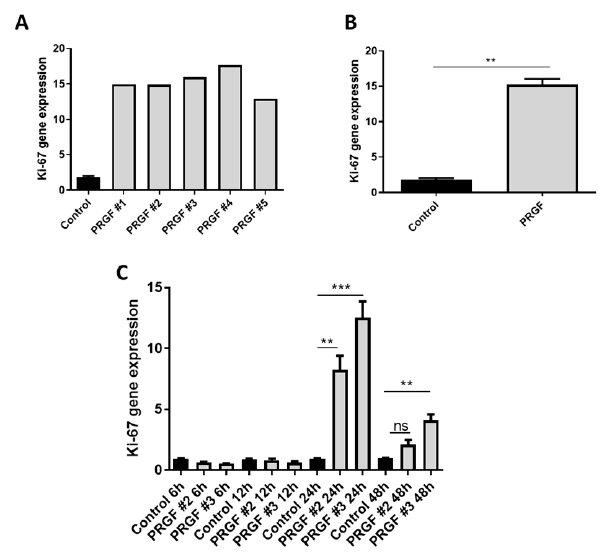
Figure 6. PRGF treatment of primary human fibroblasts induced Ki-67 gene expression. ( A , B ) Human primary fibroblasts were stimulated with PRGF from five different donors (PRGF #1-PRGF #5) for 24 h. Ki-67-gene expression was analyzed by real-time PCR. Shown are induction levels of separate donors ( A ) or combined of all 5 different donors ( B ) ( n = 5; ** p < 0.01, Mann-Whitney U test). ( C ) Primary human fibroblasts were stimulated with PRGF from two donors for 6, 12, 24 and 48 h. Ki-67-gene expression was analyzed by real-time PCR. Shown are means ± s.e.m of three stimulations (** p < 0.01, *** p < 0.001; ns = non-significant, ANOVA with Bonferroni’s multiple comparisons test).